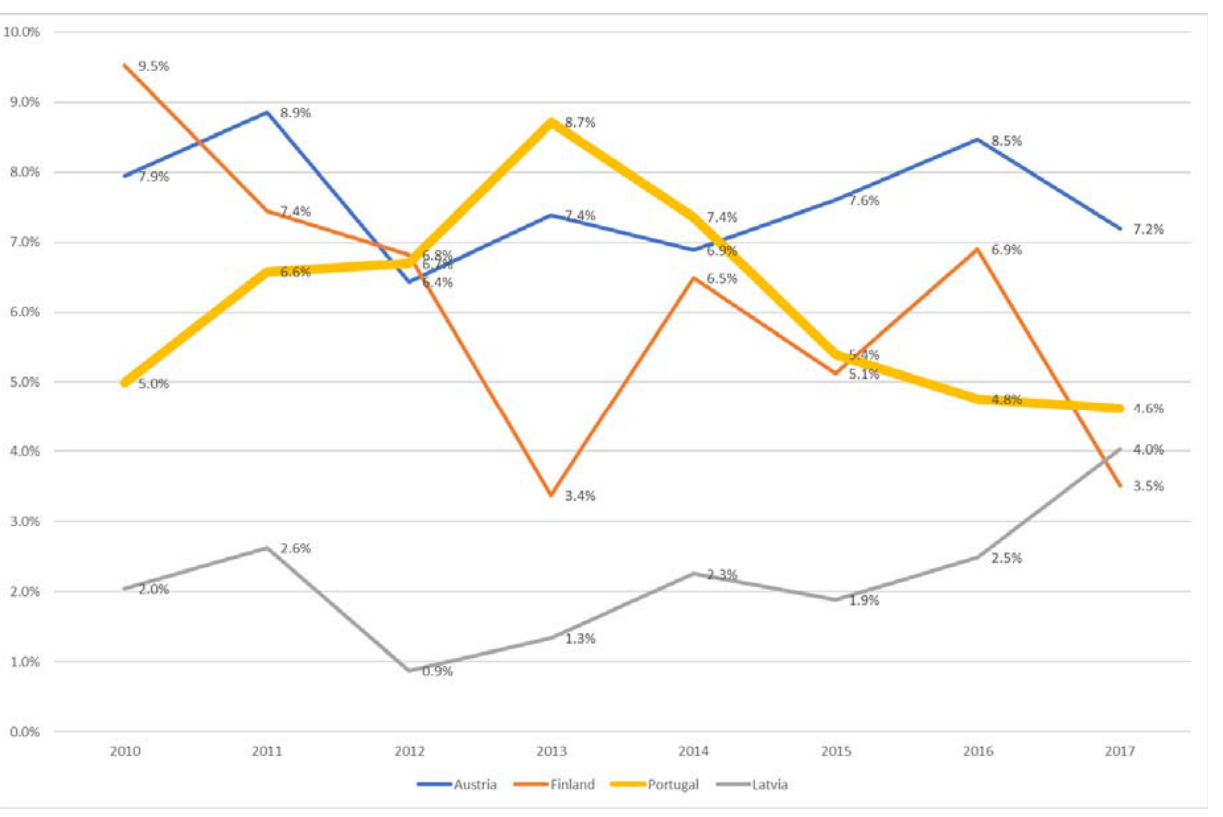
Figure 1. Evolution of the share of gross fixed capital formation invested in ICT equipment, software, and databases in the total gross fixed capital formation in the automotive sector in a selection of countries at current prices. (Source: OECD STAN Industrial Analysis (2020 ed.), accessed on 30 April